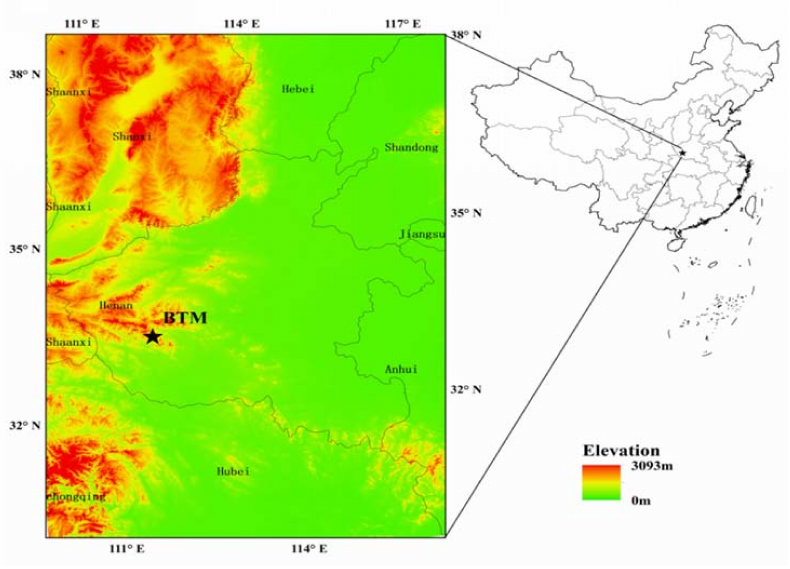
Figure 1. The geographical location of study site (BTM: Baotianman). Flux tower was installed at an altitude of 1410.7 m, with a slope of less than 15 ◦ (33 ◦ 29 (cid:48) 59 (cid:48)(cid:48) N, 111 ◦ 56 (cid:48) 07 (cid:48)(cid:48) E) (Figure 2). We set up a 1-hectare plot centered around the flux tower and conduct vegetation survey in 2014. Quercus aliena was the dominant species in the natural oak forest ecosystem. Lindera obtusiloba , Meliosma flexuosa , Tilia nobilis , Corylus chinensis , and Tilia tuan were also distributed in the stand. The average height of trees in the plot was 18 m, while the average diameter at breast height (DBH) was 19.8 ± 2.8 cm in 2014. Shrubs included Lonicera hispida , Viburnum betulifolium , Sambucus williamsii , Forsythia suspensa , Spiraea dasyantha , and Litsea tsinlingensis .